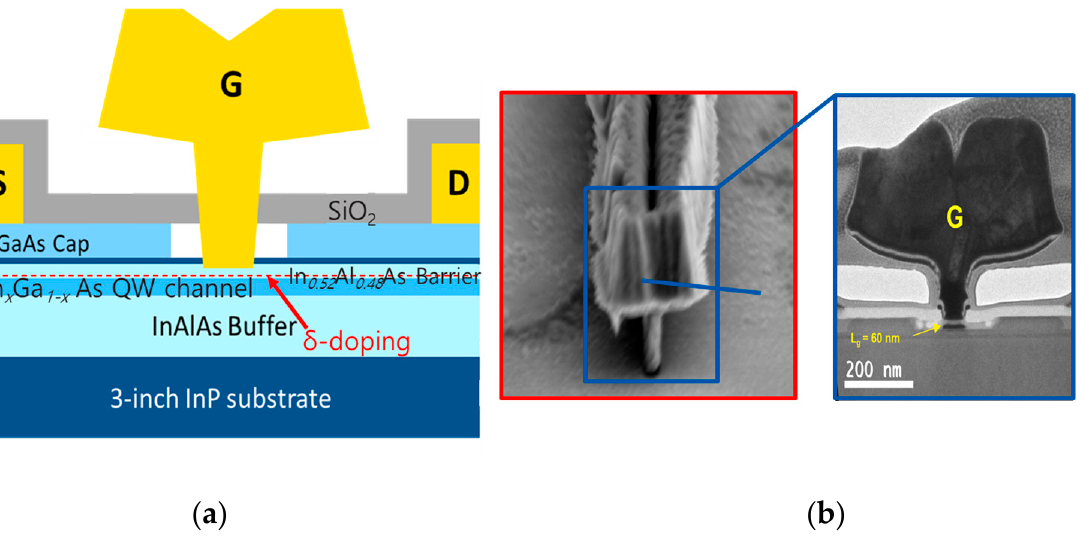
Figure 1. ( a ) Cross-sectional schematic, and ( b ) TEM images of advanced In x Ga 1 − x As QW HEMTs [4]. Figure 2a illustrates a complete distributed equivalent circuit model for R S , comprising three regions. One is the source ohmic electrode region (Region-I), where the electrons are injected from the ohmic metal to the In 0.53 Ga 0.47 As cap and then to the In x Ga 1 − x As QW channel through the In 0.52 Al 0.48 As barrier, which is governed by a three-layer TLM system. Another is the source access region (Region-II), where the electron transfer mechanism is governed by a cap-to-channel two-layer TLM system with transfer length ( L T_barrier )